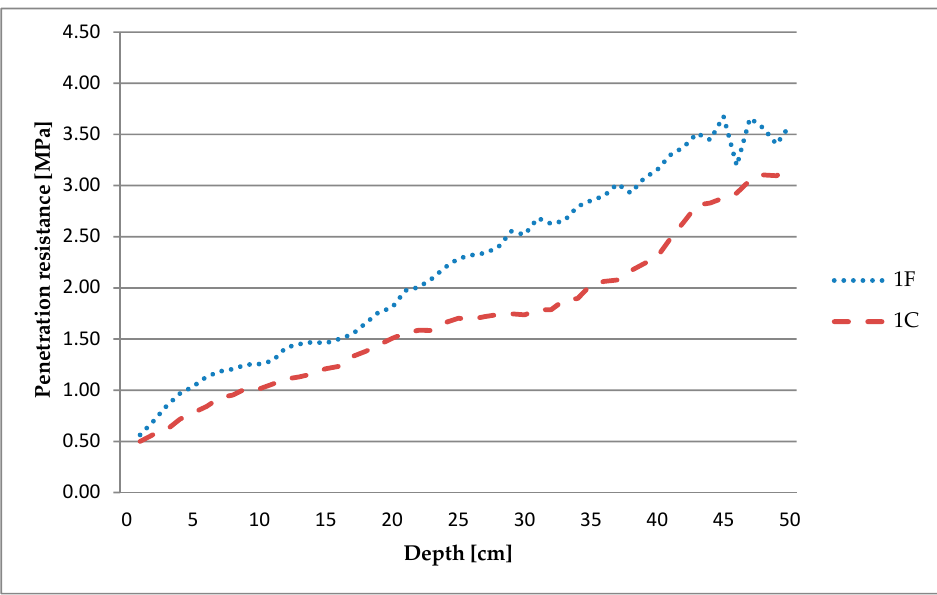
Figure 3. Soil compaction at sites 1F and 1C.